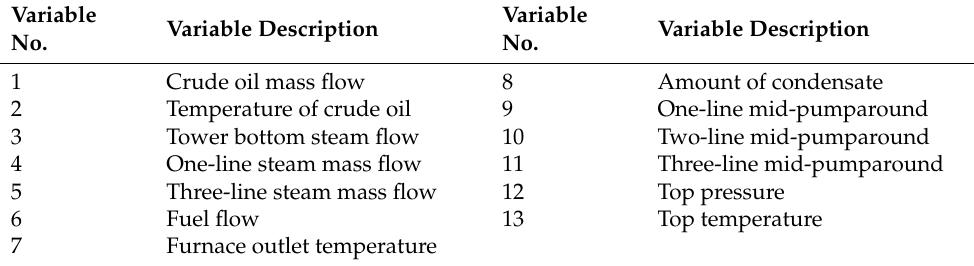
Table 7. Prediction parameters of atmospheric two-line energy efficiency.